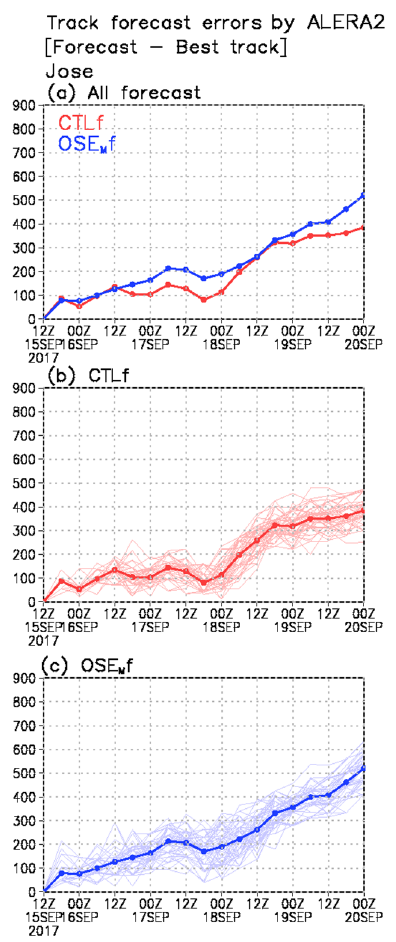
Figure 8. ( a ) Central position error for Hurricane Jose between 1200 UTC 15 September 2017 and 0000 UTC 20 September 2017, predicted by CTLf (red) and OSE M f (blue). Central position error was calculated as the difference between predicted track and best track for ensemble mean (thick line) and ensemble members (thin lines) of ( b ) CTLf and ( c ) OSE M f.